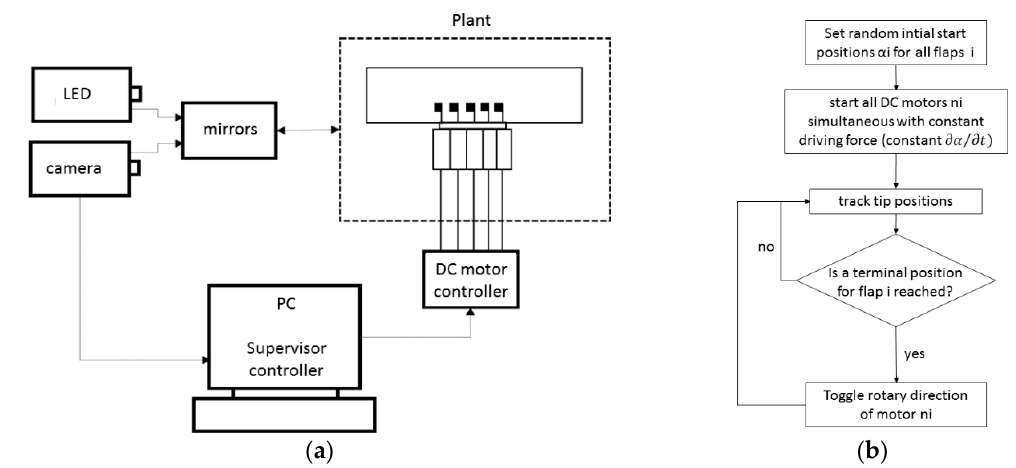
Figure 4. Schematic view of the integrated mechatronics ( a ) and the feedback loop chart ( b ).